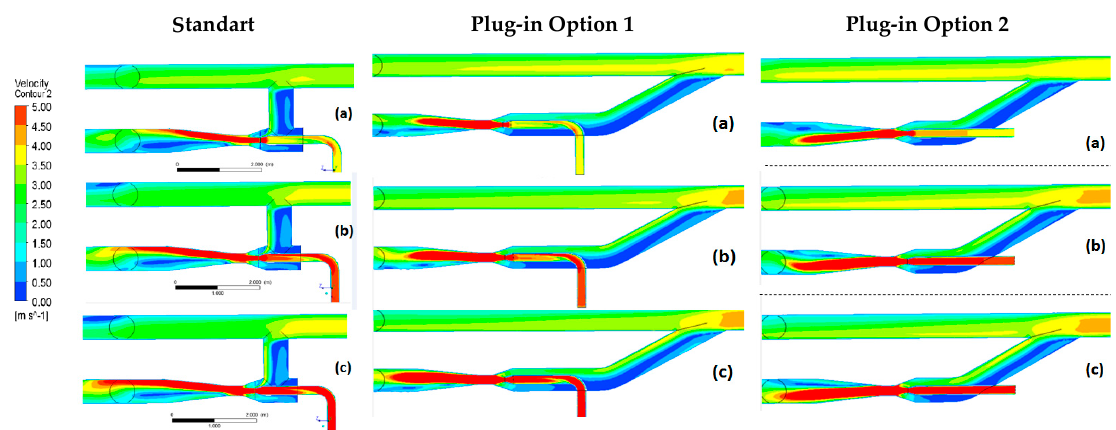
Figure 17. Nondimensional Flow Rate in the loop using a Jet Pump.